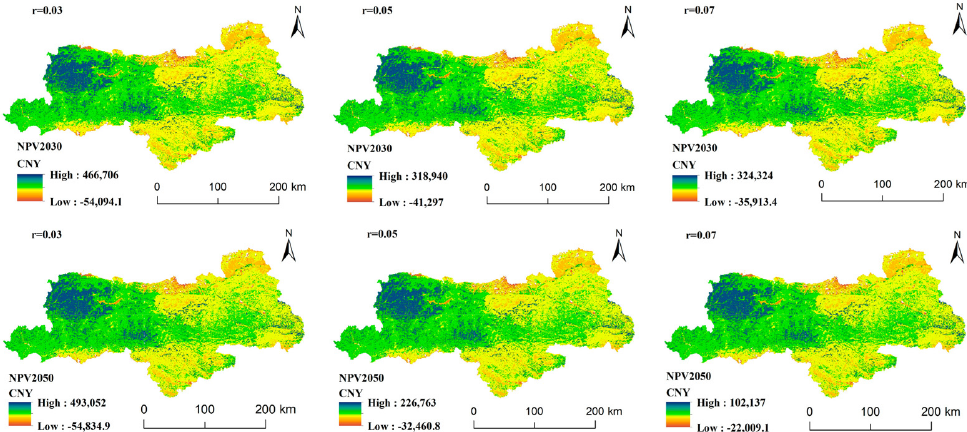
Figure 9. Spatial distribution of carbon sink value in Qinling Mountains in 2030 and 2050. Table 5. Carbon sink value of Qinling Mountains under different discount rates in 2030 and 2050. r =